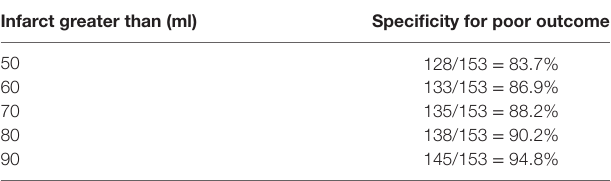
Table 2 | Specificity of a poor outcome (dependent living or death, i.e., modified Rankin scale 3–6) related to infarct size on the 24-h scan. infarct greater than (ml)